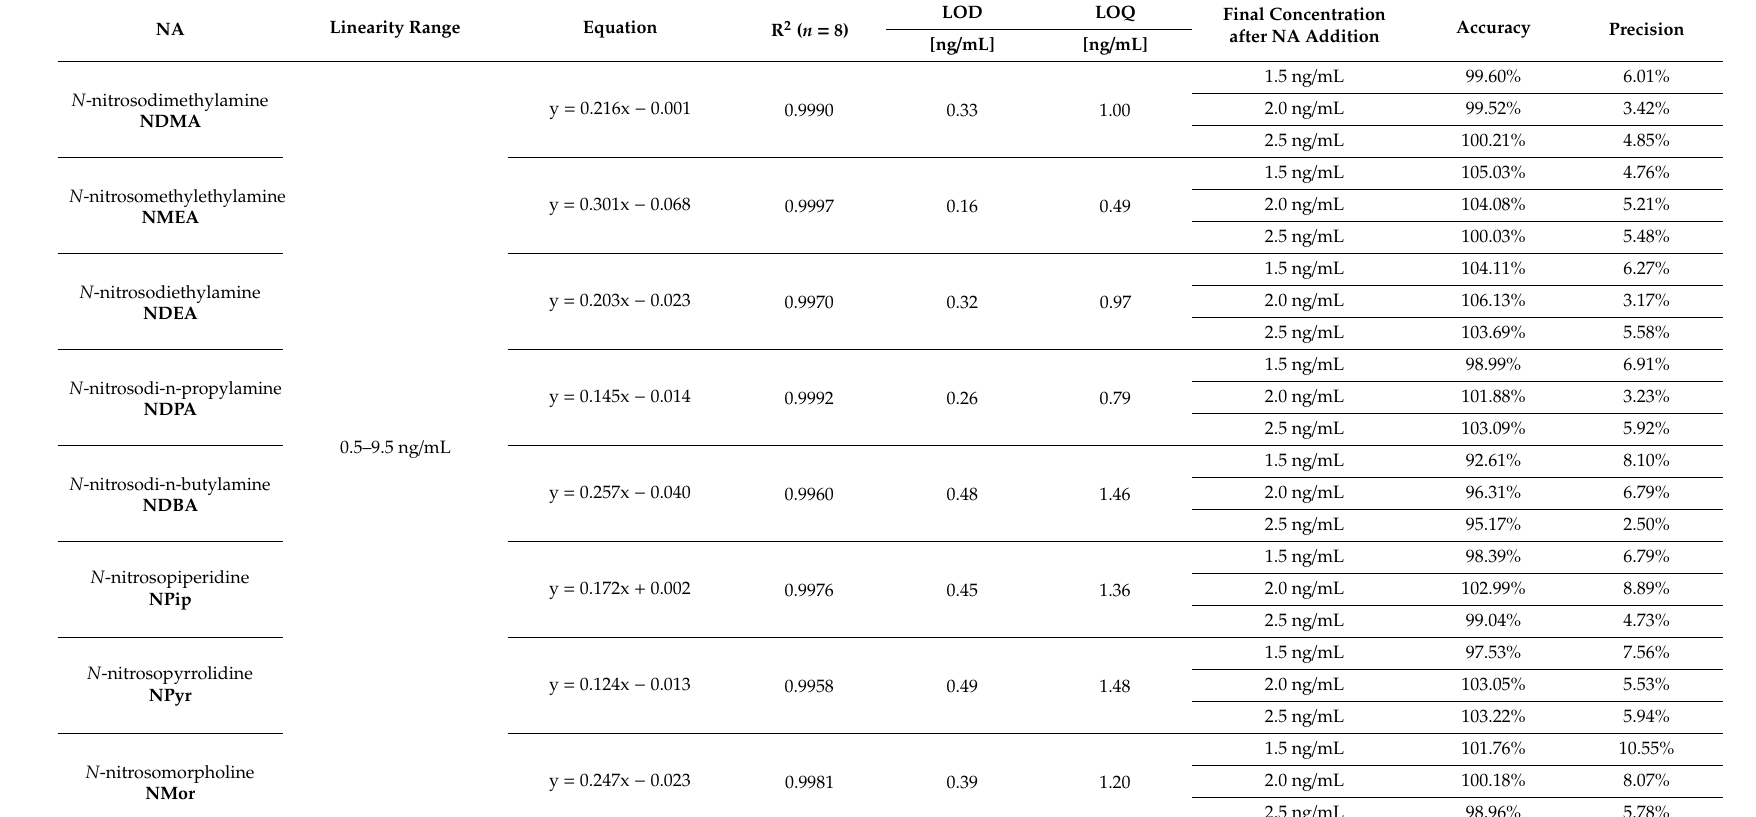
Table 1. Validation parameters for GC-MS / MS analysis of